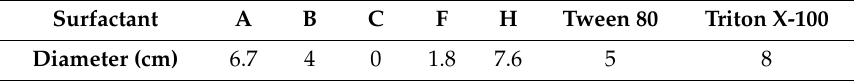
Table 3. Clear zone diameter for oil spreading test in surfactant solutions (500 mg / L).